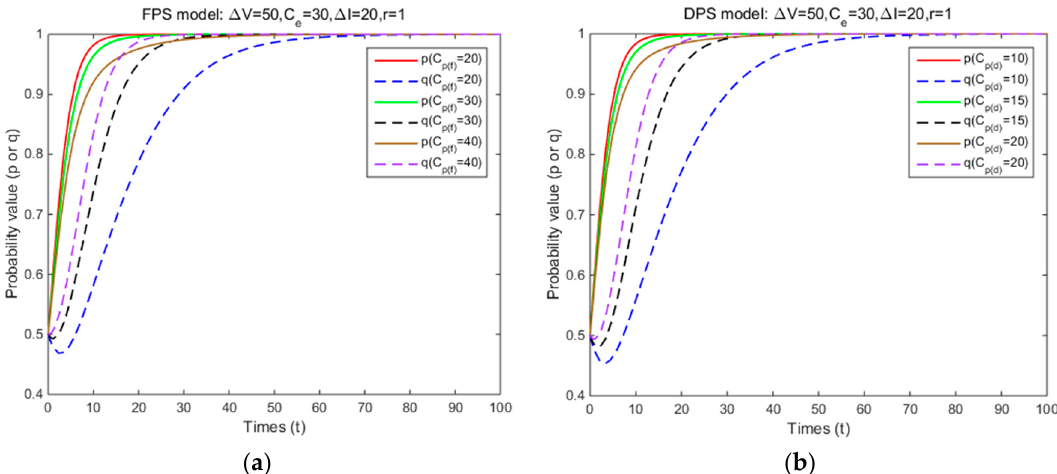
Figure A1. The effects of penalty amount on strategy probabilities of cyclists and law enforcement under FPS ( a ) and DPS ( b ) (Situation 1).